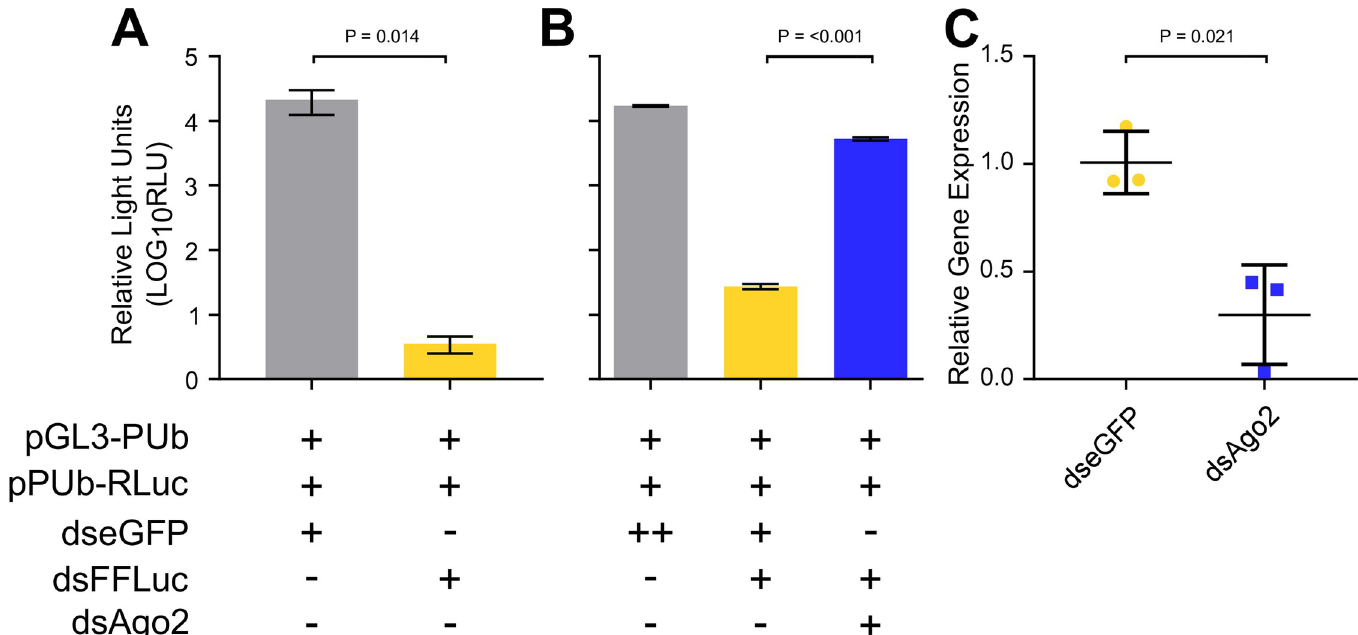
Fig 5. The PP9ad cell line contains an exo-siRNA pathway. PP9ad cells were transfected with a combination of reporter plasmids and dsRNAs, and harvested for reporter expression by luciferase assay, or to determine gene expression by quantitative PCR. (A) Effects on normalised FFLuc expression in PP9ad cells when transfections of reporter plasmids were supplemented with 100 ng dsRNA targeting eGFP (dseGFP) or FFluc (dsFFLuc). FFLuc expression was normalized to a RLuc internal control (unpaired t test, T = 4.21, P = 0.014). (B) PP9ad cells were transfected with either 100 ng dsRNA targeting eGFP (dseGFP) or Ago2 (dsAgo2) 24 h prior to transfection with pGL3-PUb and pPUb-RLuc expression plasmids and 20 ng dseGFP or dsFFLuc as indicated (ANOVA, F = 1869.21, P = < 0.001). FFLuc expression was normalized to a RLuc internal control. (C) The relative abundance of Ago2 present in PP9ad cells transfected with either 100 ng dseGFP or dsAgo2 was determined. Cells were harvested and relative abundance of Ago2 determined by RT-qPCR at 48 h.p.t. (unpaired t test, T = 4.48, P = 0.021). Data are representative of three independent replicates and presented as the mean value ± SD.